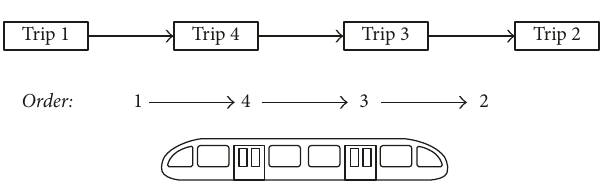
Figure 2: Simple example of connecting order.